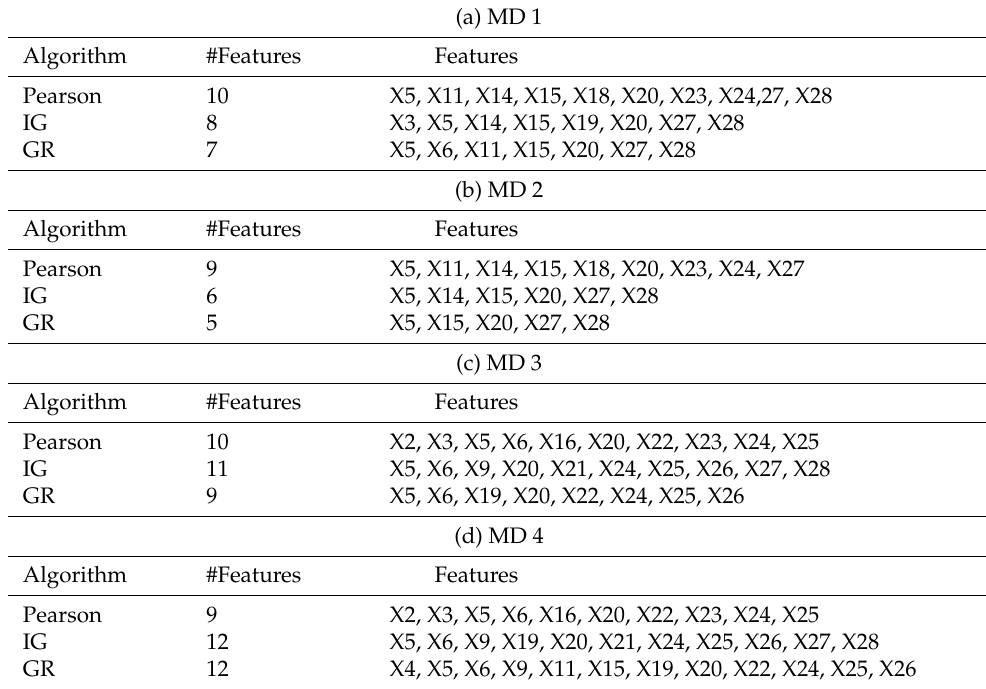
Table 5. The results for the different feature-extraction methods for the 4 sample groups.